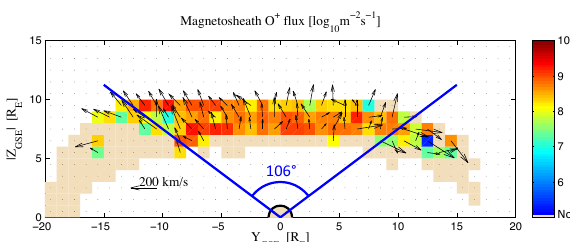
Fig.3. TheescapefluxintheYZ GSE plane,showingthespatialdistributionofourmeasurements.Theobserved Fig. 3. The escape flux in the YZ GSE plane, showing the spatial dis- O + fluxisgivenbythecolorscaletotheright, rangingfrom10 5 − 10 10 m − 2 s − 1 . Regionscoloredinbeige tribution of our measurements. The observed O + flux is given by correspondstoregionswheremeasurementshavebeentakenplacebutnoO + hasbeenobserved. Theblack the color scale to the right, ranging from 10 5 –10 10 m − 2 s − 1 . Re- arrowscorrespondstotheYZ-componentoftheaverageflowvelocity.Themajorityoftheobservedsignificant escapefluxesarewithinanangularextentof106 ◦ . gions colored in beige correspond to regions where measurements have been taken place but no O + has been observed. The black ar- netopause,becauseofthelargevariationofitsposition. ManyobservationsofO + havebeenmade 130 rows correspond to the YZ-component of the average flow velocity. uptoseveralhoursaftercrossingthemagnetopause,leavinguswithnocontrolofthemagnetopause position at the given measurement points. 85 % of the recorded magnetopause crossing are taking The majority of the observed significant escape fluxes are within an place within segments 2, 3 and 4. As it turns out, these segments will contribute most to the total angular extent of 106 ◦ . fluxcalculation. Magnetopausecrossingsarehoweverexperiencedinallofthesegments,reflecting thehighvariabilityofthemagnetopauseposition. 135 The spatial segments defined in Fig. 1 have been used to investigate the characteristics of the O + flux in the outward direction relative to the Earth. The results are demonstrated in Fig. 2. Plot A shows the average O + flux of each segment, with error bars indicating one standard variation. ThereisacleartrendthatthemeasuredfluxesingeneraldecreasewiththedistancefromEarth. The decreasefromsegment1tosegment7isaboutoneorderofmagnitude(10 10 to10 9 m − 2 s − 1 ). This 140 result could give the impression that the closer the segment is to Earth the more it contributes to